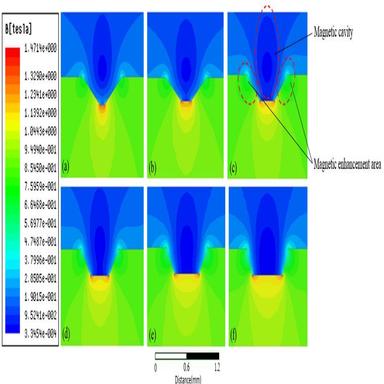
Simulation results of different trapezoid short side lengths for HMM; (a) Short side length of 0.1 mm; (b) Short side length of 0.2 mm; (c) Short side length of 0.3 mm; (d) Short side length of 0.4 mm; (e) Short side length of 0.5 mm; (f) Short side length of 0.6 mm.